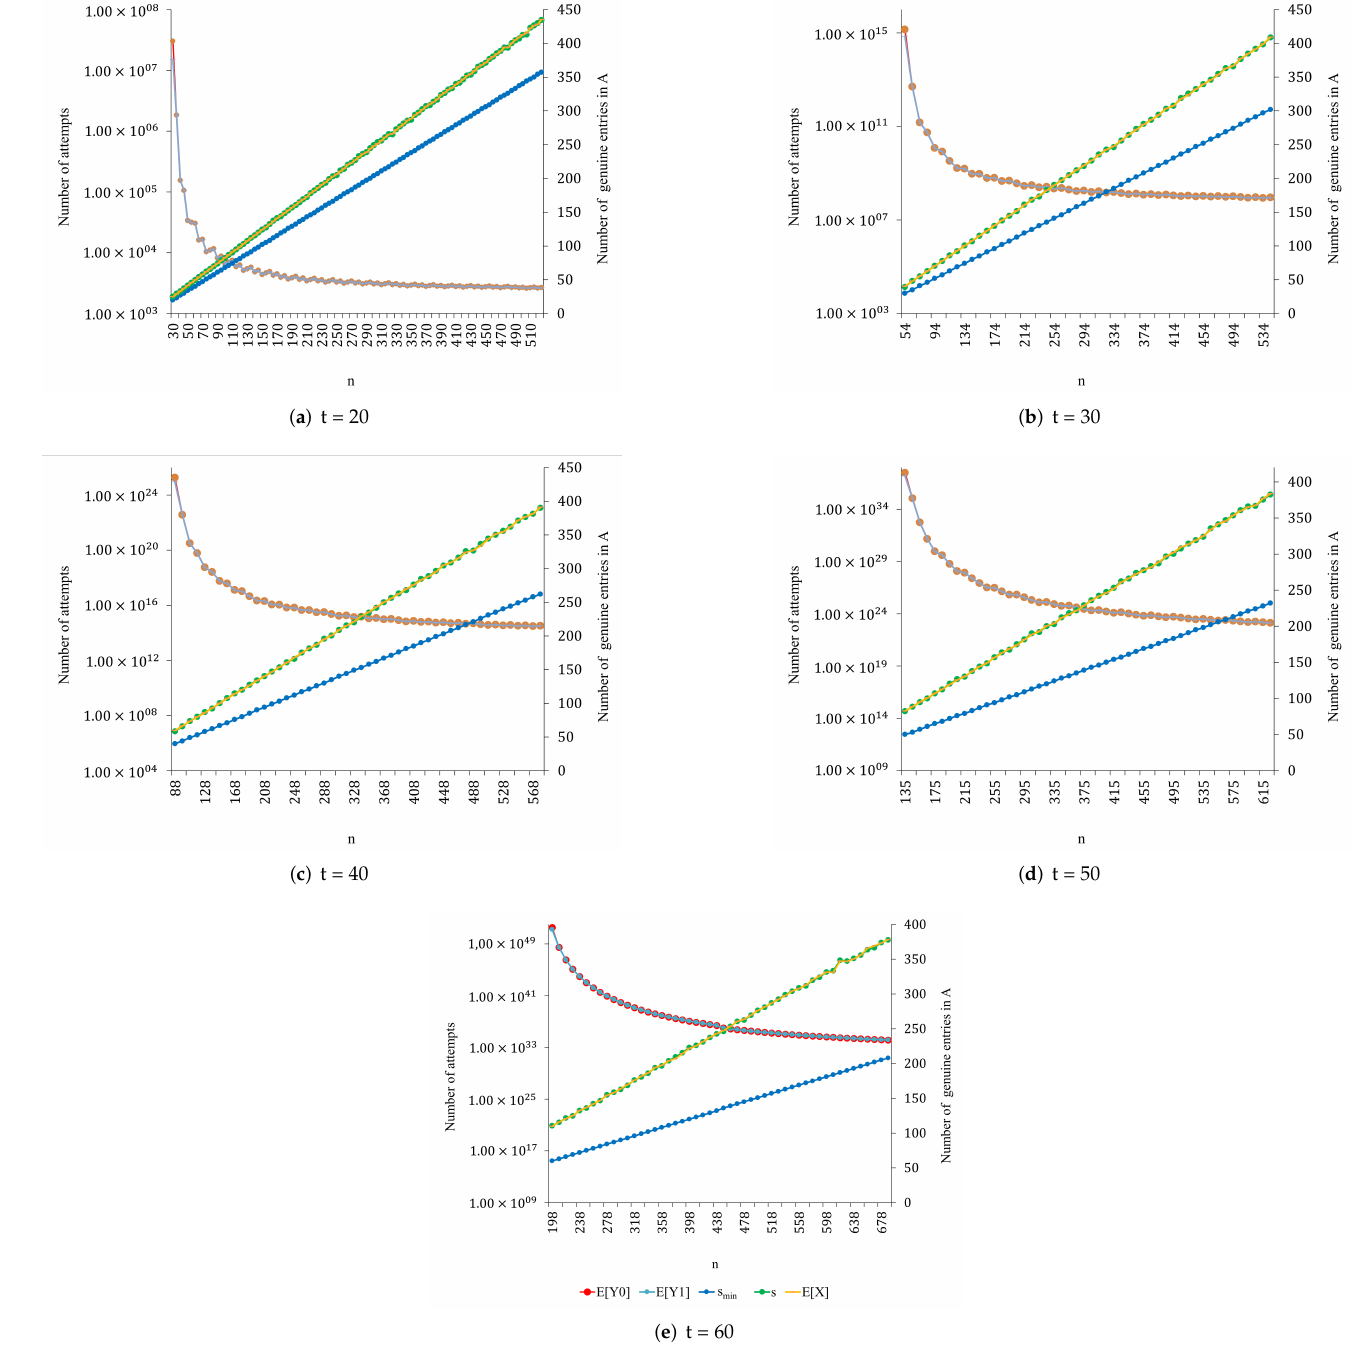
Figure 5. Results obtained for p min = 0.98 ∈ P , t ∈ T , and proper values of n